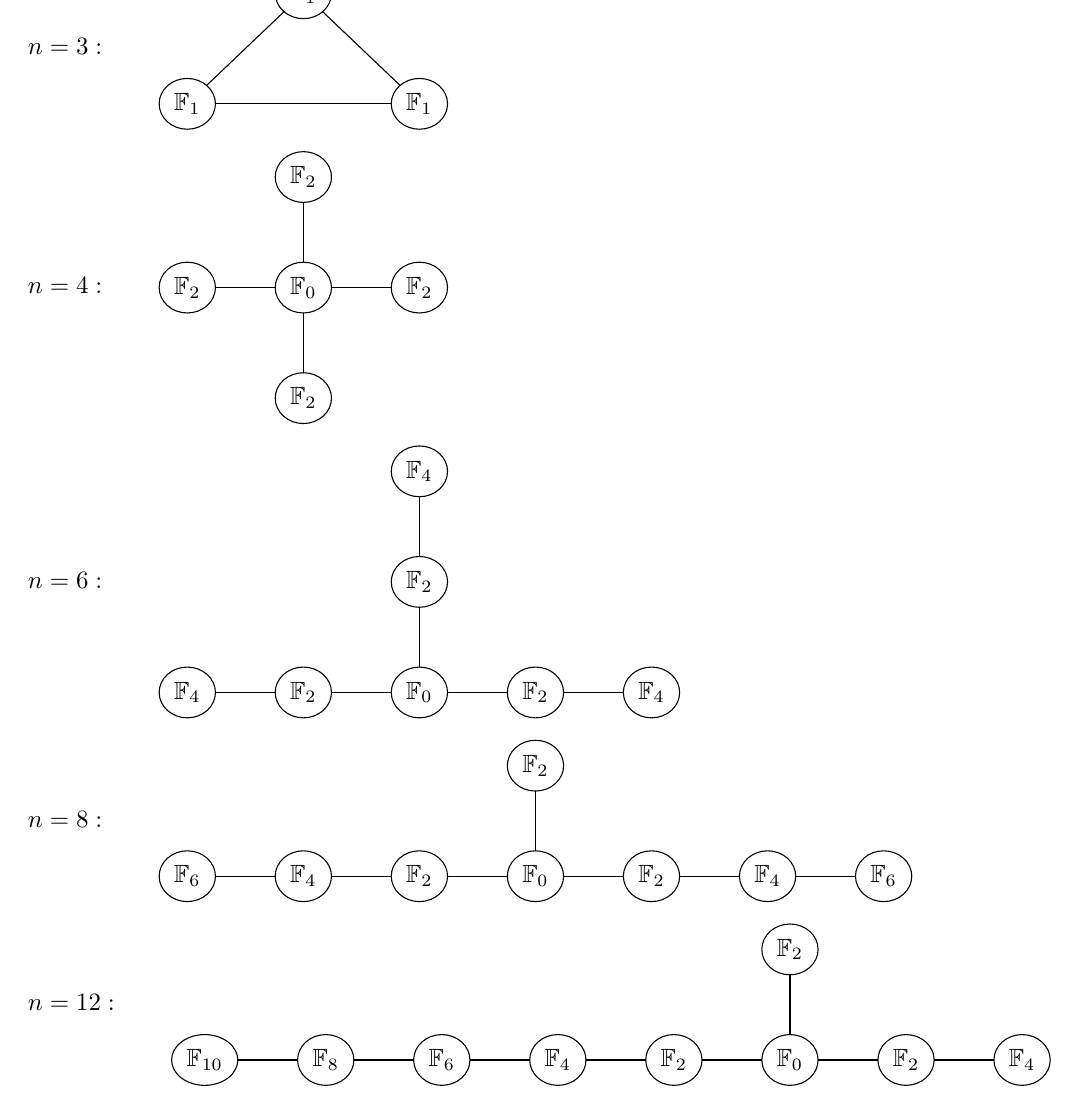
Figure 5 . Schematic structure of the geometries of certain NHCs as Dynkin graphs: the nodes correspond to surfaces while the links correspond to